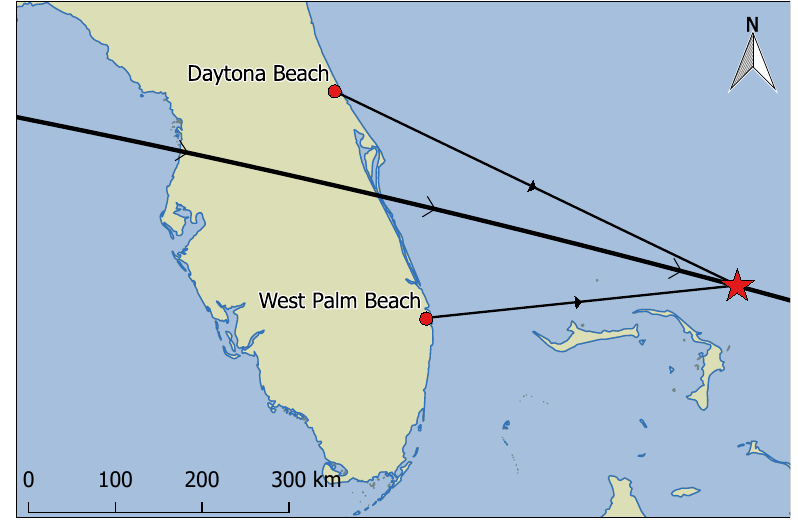
Figure 9. Geometry and ground track of the simultaneous observation of ASTRO-H Object A from Daytona Beach and West Palm Beach, FL on 7 May 2016. Object A at 09:31:05 UTC is marked by the